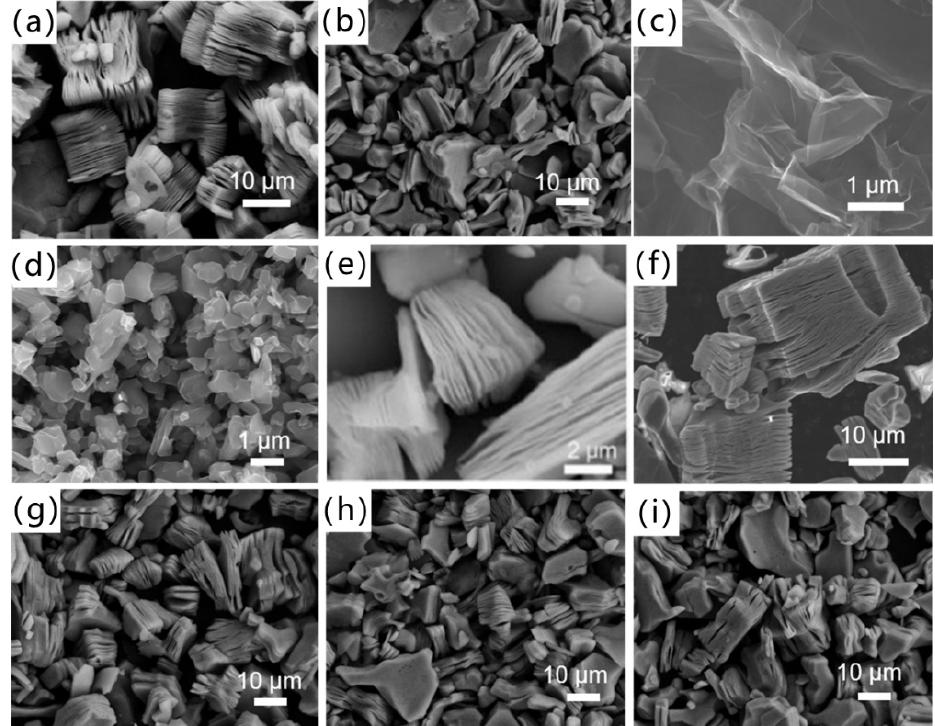
Fig. 15 Morphologies of MXenes in SEM. (a) SEM image from MXene etched with high concentration HF solution. (b) SEM image from MXene etched with diluted HF solution. Reproduced with permission from Ref. [136], © American Chemical Society 2019. (c) LiF/HCl solution-etched MXene treatment by solvothermal method. (d) Ti 3 C 2 T x MXene obtained by etching submicron Ti 3 AlC 2 grains grown in molten salt. Reproduced with permission from Ref. [137], © Royal Society of Chemistry 2018. (e) SEM image of multilayer MXene by freeze-drying. Reproduced with permission from Ref. [138], © Elsevier 2020. (f) Supercritical drying. SEM images of MXene samples annealed in (g) Ar (H 2 ), (h) Ar (H 2 O), and (i) NH 3 . Reproduced with permission from Ref. [136], © American Chemical Society